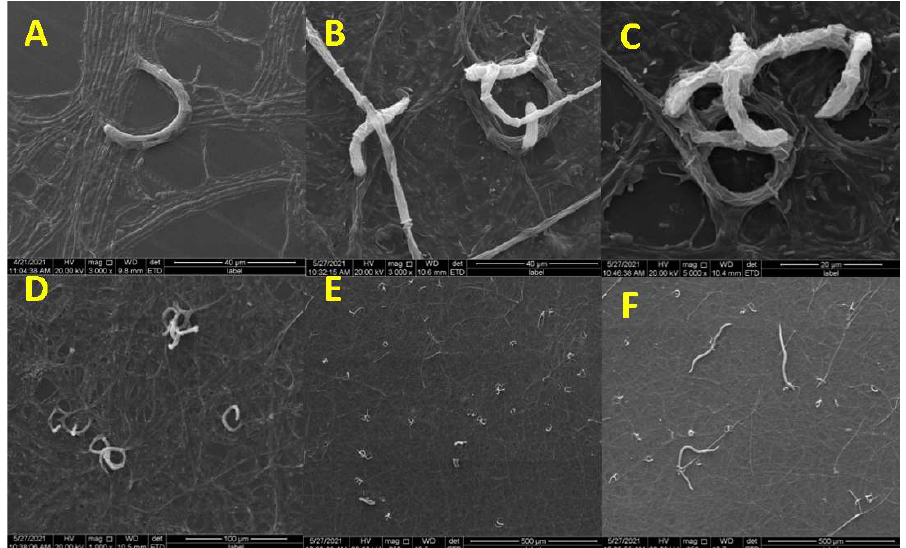
Figure 1. Trap (adhesive three-dimensional network) formation of D. flagrans . ( A ) The loop was formed; ( B ) The connection of hyphal and loop; ( C ) The formation of a three-dimensional